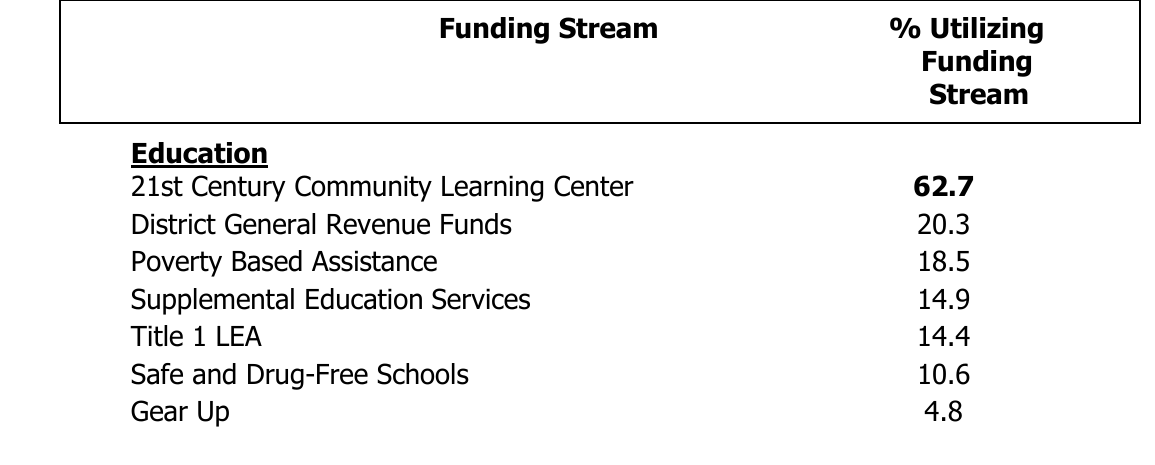
Funding Streams Utilized by ELO Providers in one Mid Western